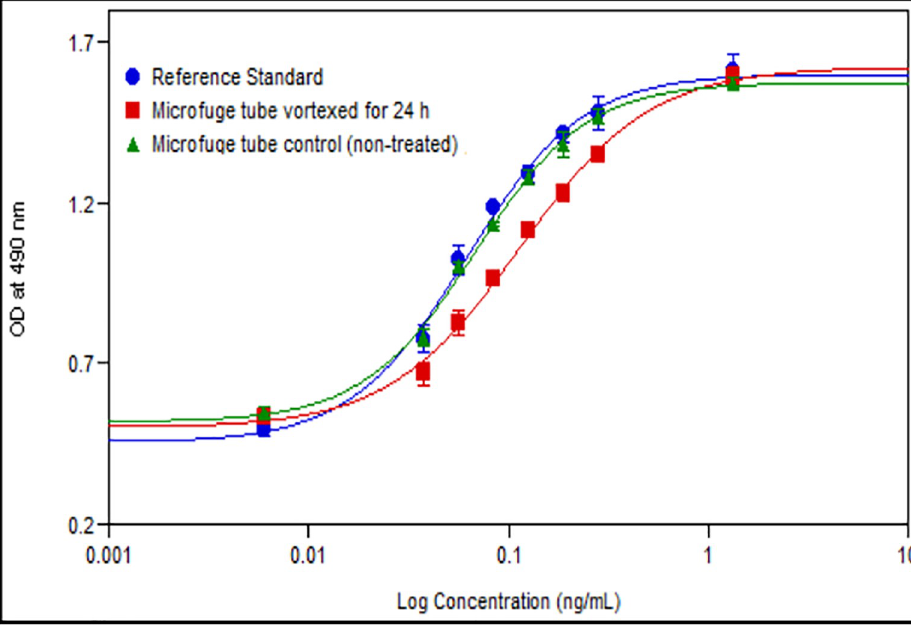
Fig 16. Representative profile for in vitro bioassay of INTP5 control (microfuge tube) and vortexed (stressed)